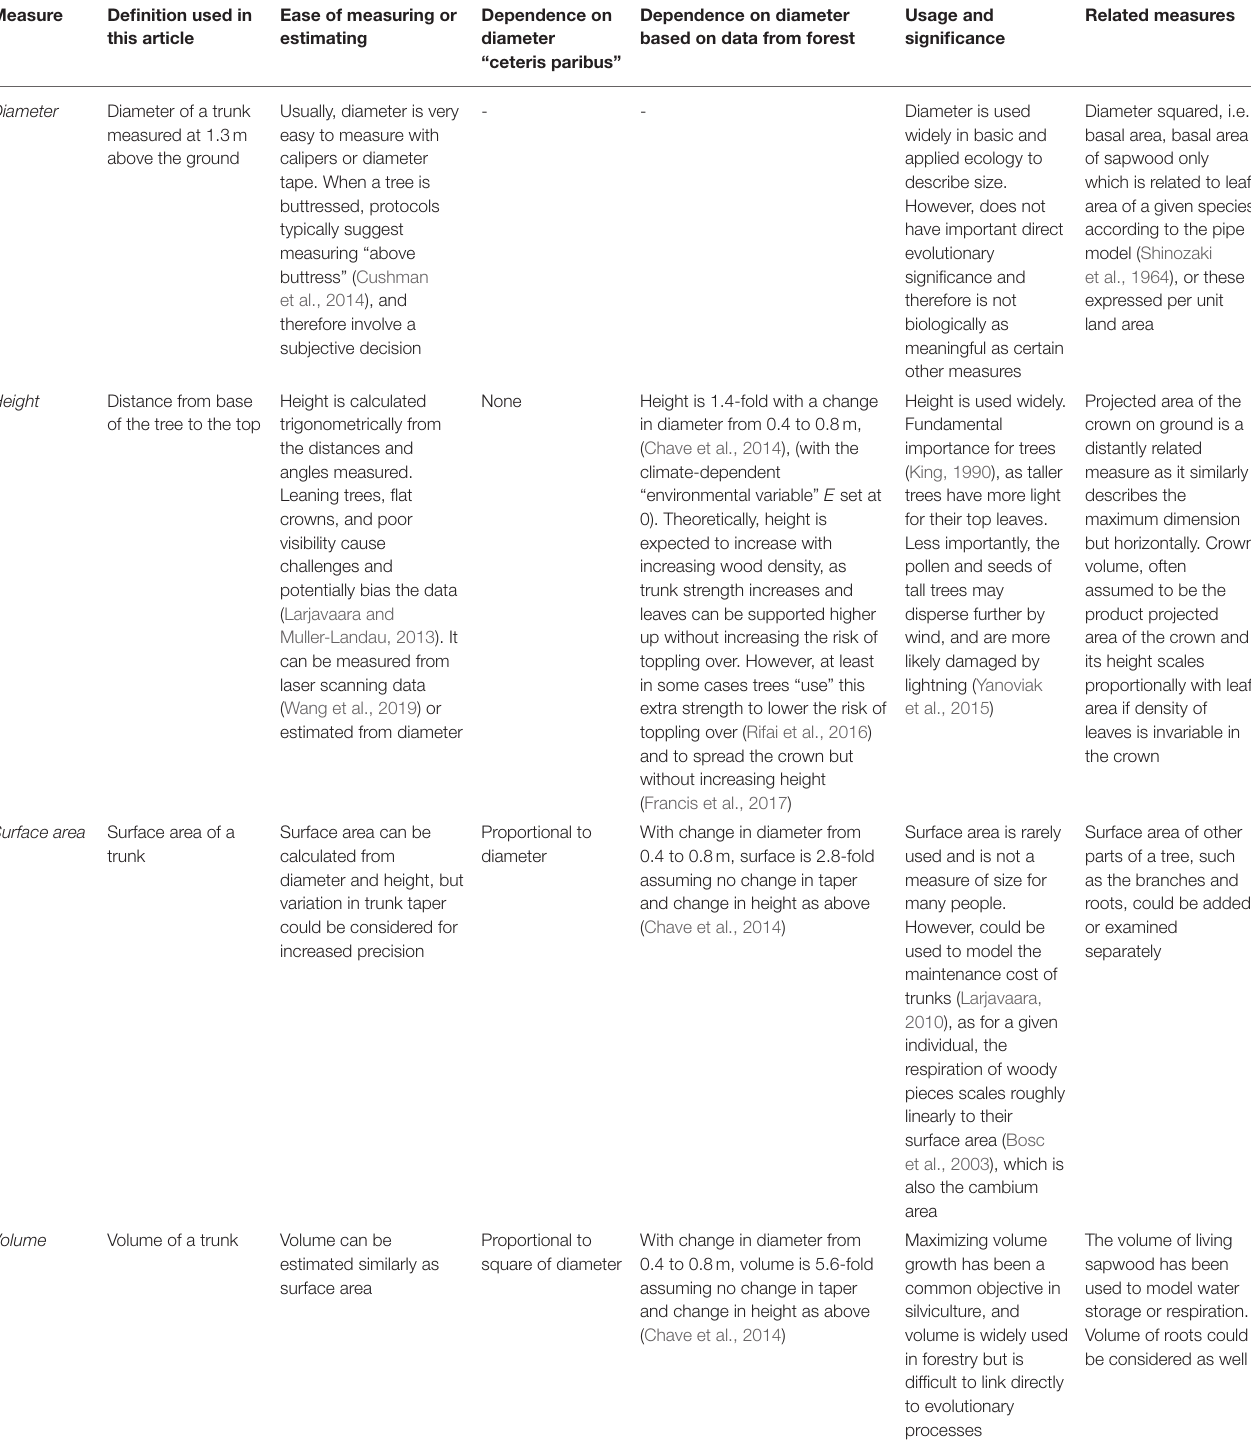
TABLE 1 | Some potential measures of tree